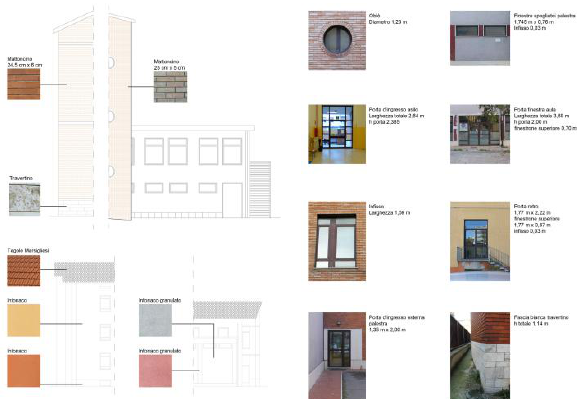
Figure 9. Photographic materials abacus of the G. Pascoli school in Milano street.